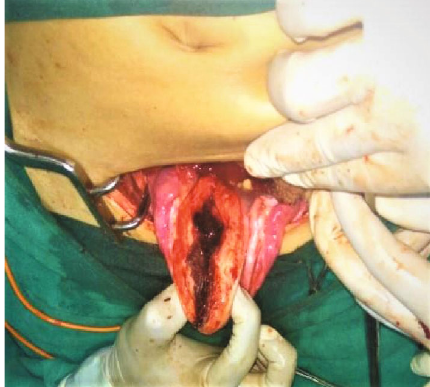
Figure 4: Haultain ’ s